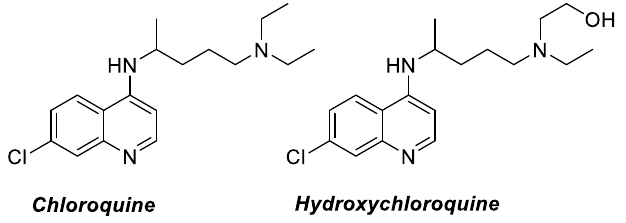
Figure 1. Chemical structures of chloroquine and hydroxychloroquine.